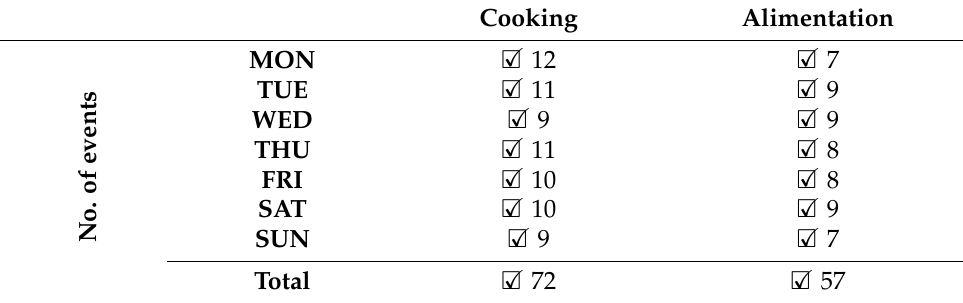
Table 19. Results of the first scenario.